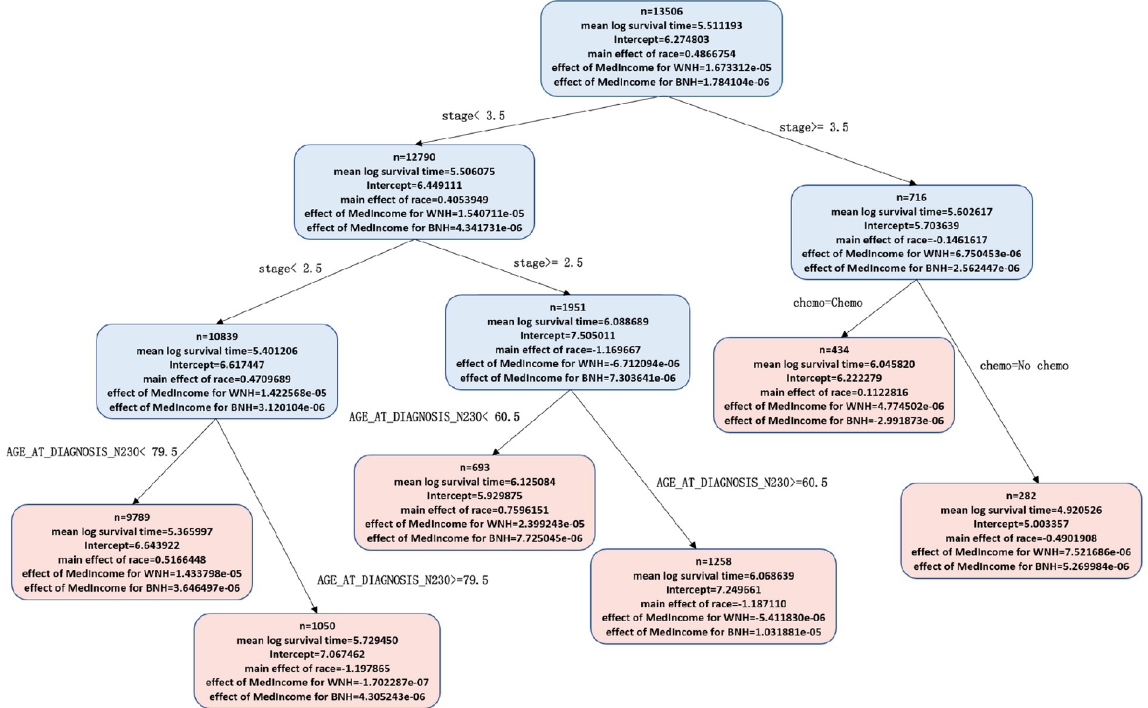
Fig 3. HPRISM tree for MedIncome. Inside each node, the HPRISM tree additionally adds the MedIncome slopes by racial group to each node.